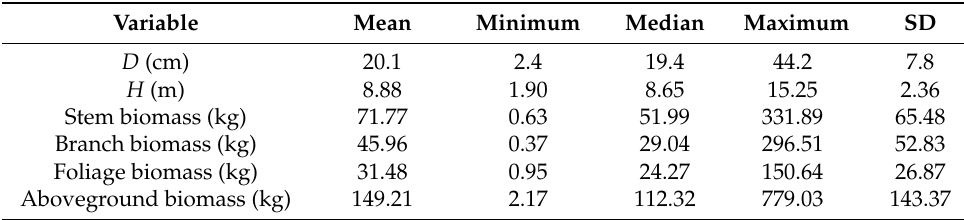
Table 1. Statistics of dendrometric variables for developing biomass